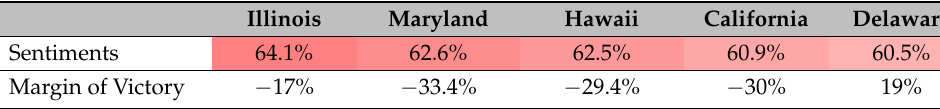
Table 5. Trump: extreme negative sentiment states with margin of victory.